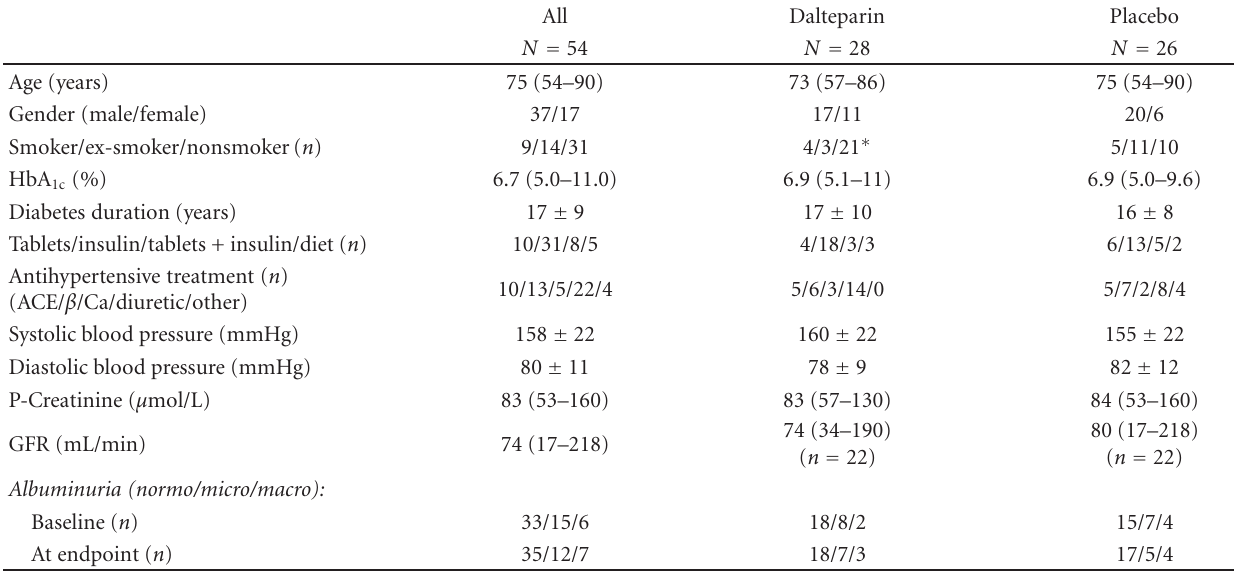
Table 1: Baseline characteristics of 54 patients randomized to dalteparin or placebo.